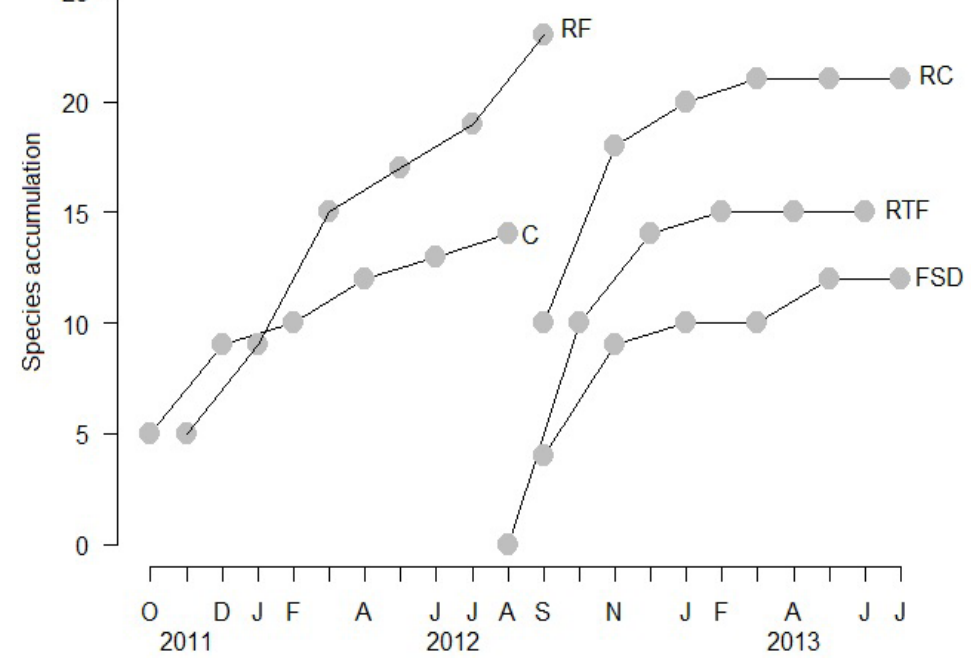
Fig 5 . Rarefaction curves for each study area using different sampling methods from 2011 to 2013. RC: Regenerating Cerrado; C: Cerradão; RTF: Restored forest; FSD: Semideciduous forest; RF: Riparian forest. Letters at the right extreme of the curves indicate the homogenous groups at rarefied